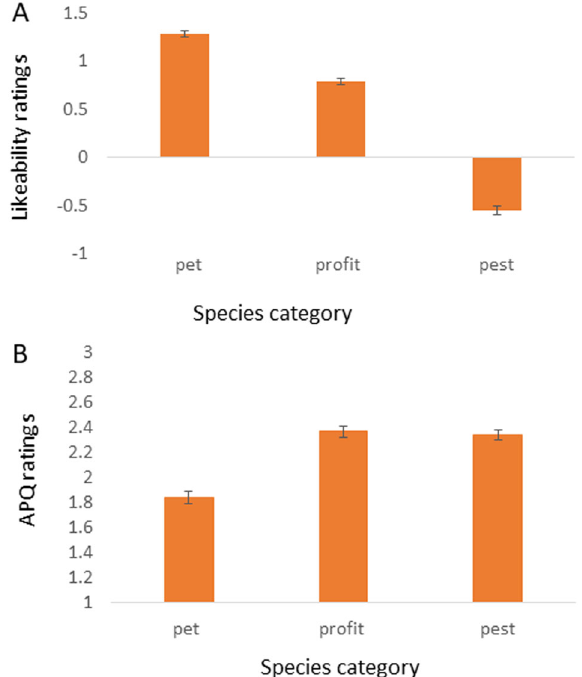
Fig. 2 Average ratings by species category: pet (cat, dog, horse, rabbit), pro fi t (chicken, cow, deer, shrimp) and pest (pigeon, rat, spider, wasp). Error bars show two standard errors of the mean. A Likeability ratings where 2 indicates a strong liking for the species category, − 2 indicates a strong disliking and 0 suggests participants are neutral/uncertain of their feelings. B APQ scores where 3 indicates a neutral attitude and scores below 3 re fl ect varying levels of disagreement with the use of the animals by species category.